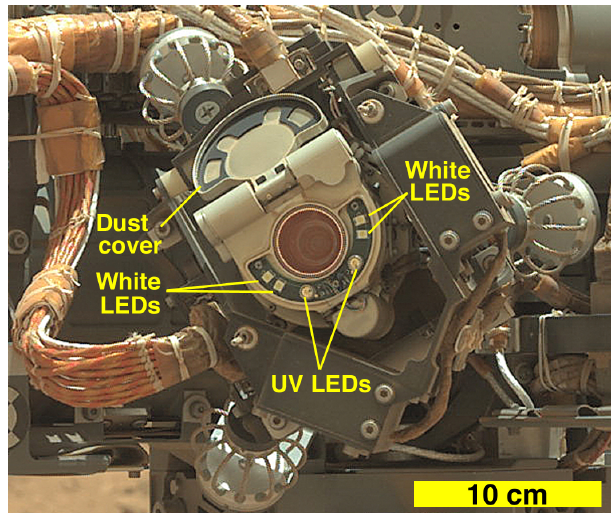
Figure 1. MAHLI camera head with dust cover open, as seen on Mars by Curiosity’s left mast camera (Mastcam-34) on sol 84, 31 October 2012 (portion of image